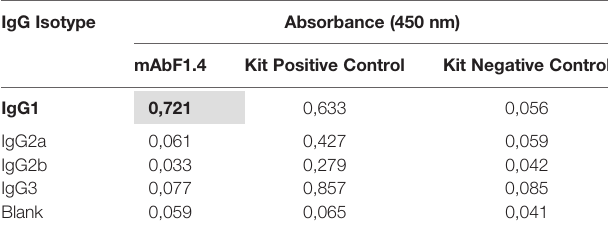
TABLE 1 | Isotyping Elisa of puri fi ed mAbF1.4